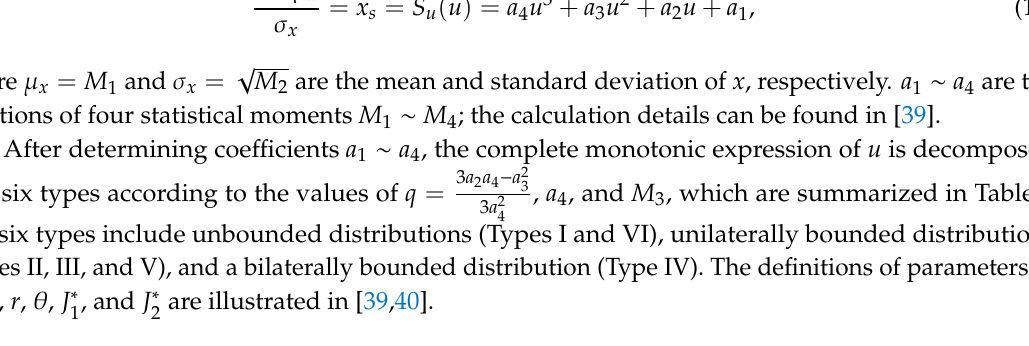
Table 1. Complete monotonic expression of u